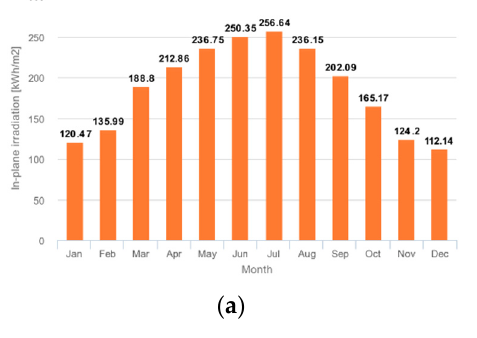
Figure 8. Monthly Solar Radiation on horizontal and 30° tilt angle in kWh/m 2 . ( a ) Horizontal plane, ( b ) 30° tilt angle.